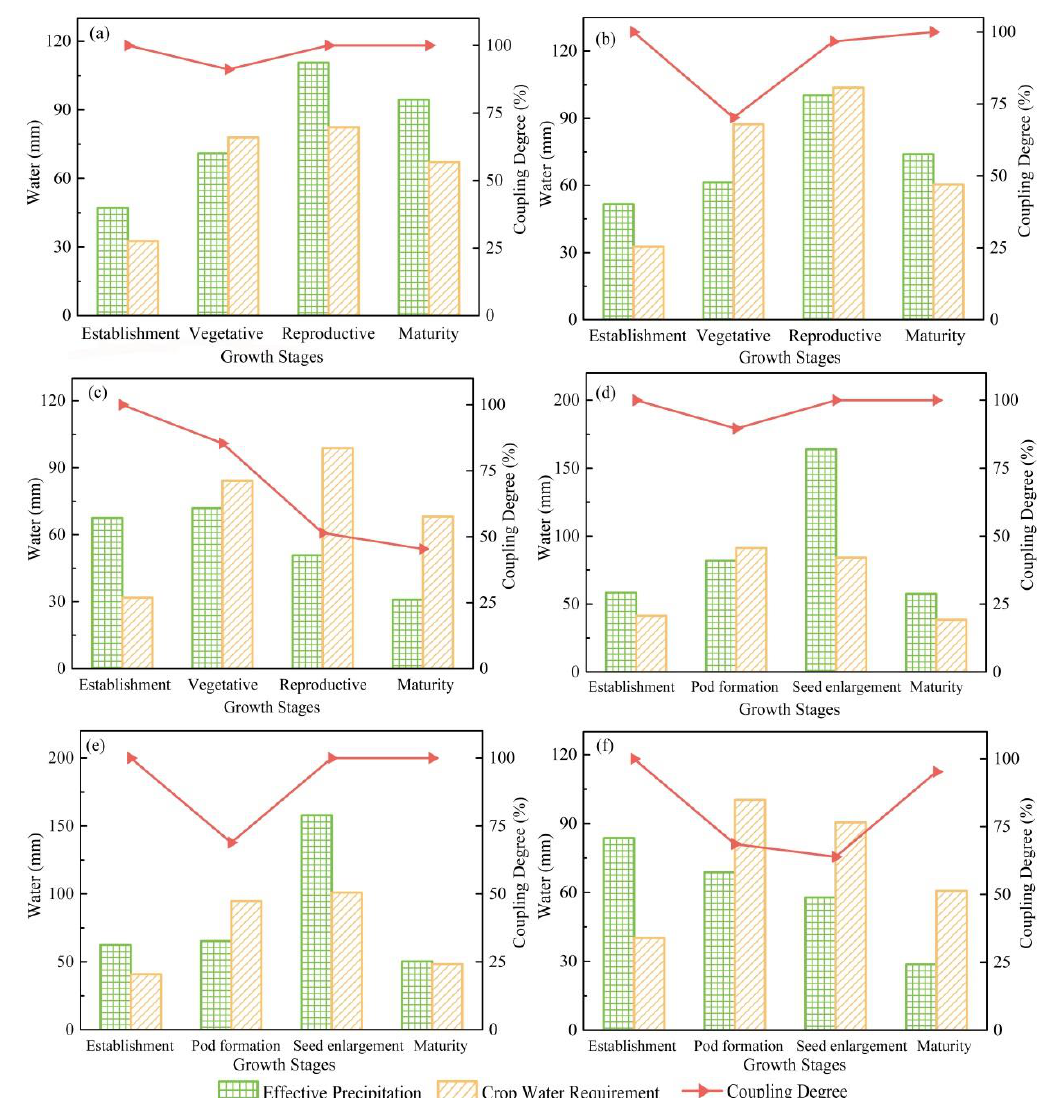
Figure 5. Coupling degree between P e and ET c . ( a ) corn wet year, ( b ) corn normal year, ( c ) corn dry year, ( d ) soybean wet year, ( e ) soybean normal year, ( f ) soybean dry year.